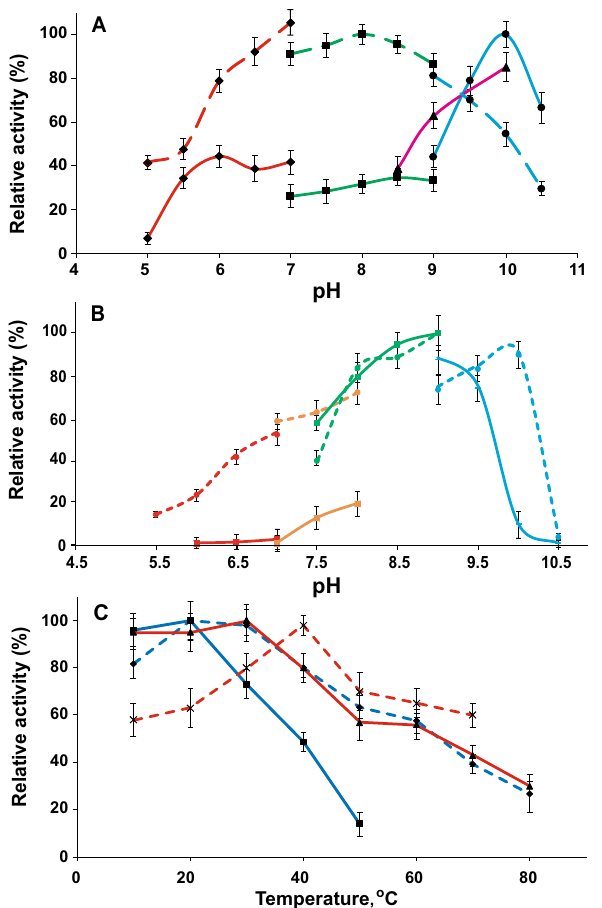
Figure 2. The effect of pH on the activity of GDHs ( A ) and GntKs ( B ) from Mtm. alcaliphilum (solid line) and Mb. luteus (dashed line). The following buffers were used for activity measurement: MES-NaOH (red line), Tris–HCl (green line), K-P buffer (orange line), CHES–NaOH (purple line), and Glycine–NaOH (blue line). 100% activity of GDH corresponds to 90 U/mg protein for Mtm. alcaliphilum GDH and 28 U/mg protein for Mb. luteus GDH; 100% activity of GntK corresponds to 20 and 56 U/mg protein for Mtm. alcaliphilum and Mb. luteus GntK, respectively. ( C ) The effect of temperature on the activity of GDHs (dark blue line) and GntK (red line) from Mtm. alcaliphilum (solid line) and Mb. luteus (dashed